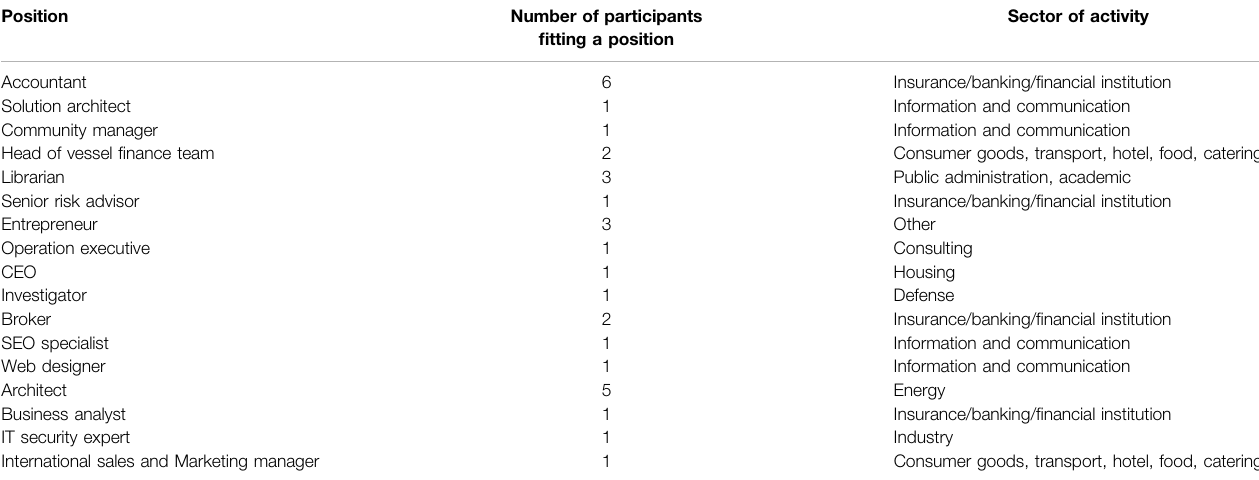
TABLE 3 | Snippet of some of our participants ’ positions. Position